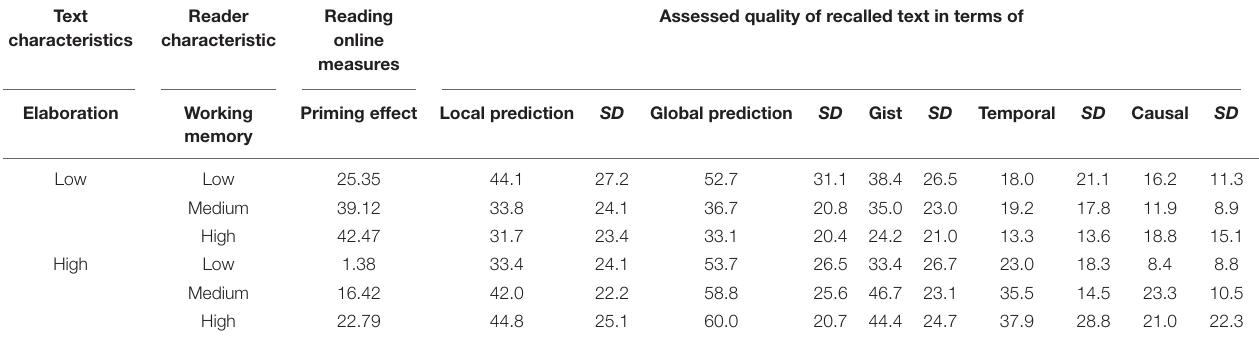
TABLE 9 | Means and standard deviations of coherence ratings in low and high elaboration reading conditions, low- and high-span groups when local predictions were activated ( n = 70). Text